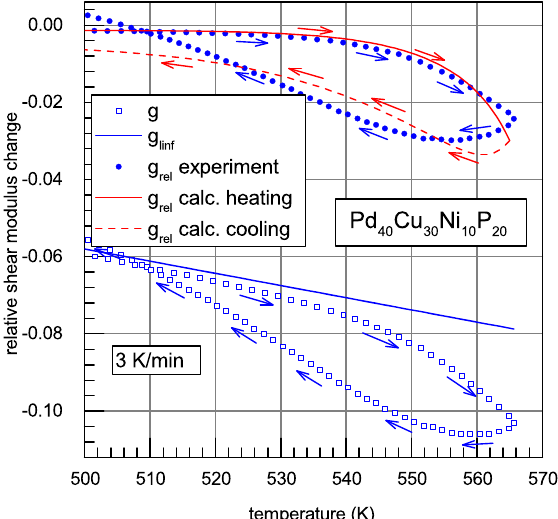
Figure 4. Temperature changes of the experimental relative shear modulus change g ( T ) Cu Ni P for glassy P d , its linear approximation g 40 30 10 20 together with the experimental and calculated relaxation parts of the relative shear modulus change g . The arrows give the sequence of heating/cooling rel